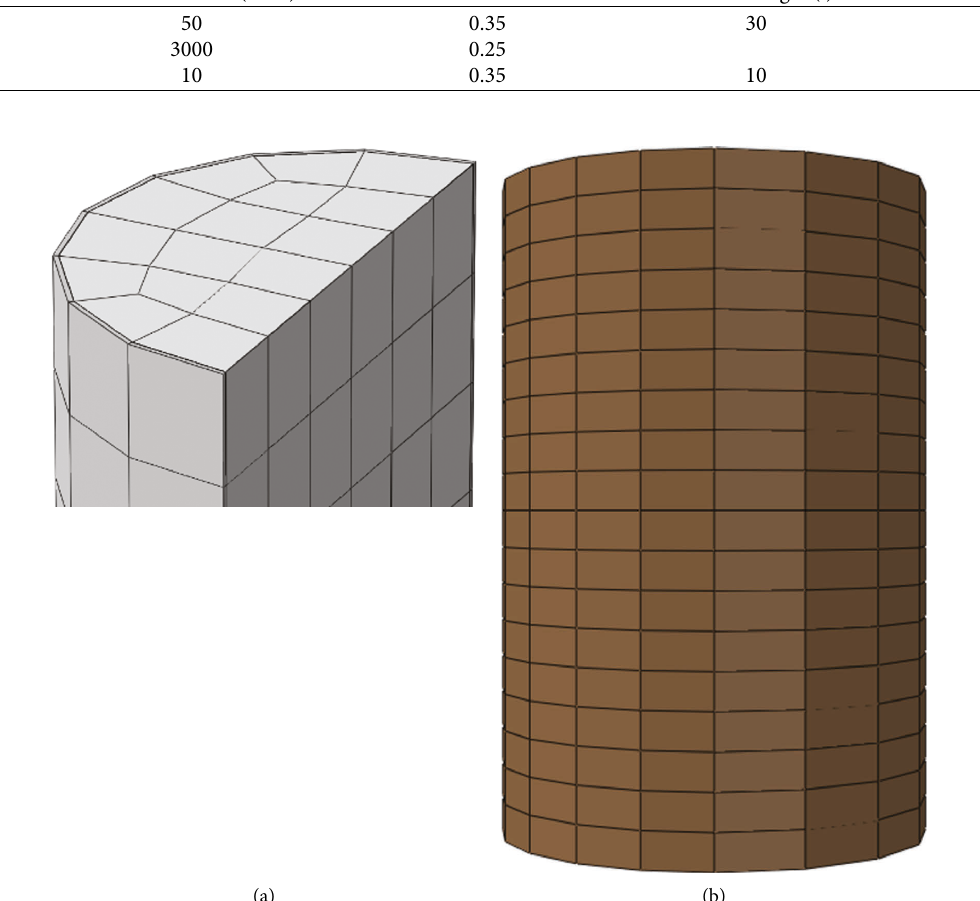
Figure 13: Grid graph of S1 pile. (a) Pile and mudcake. (b)